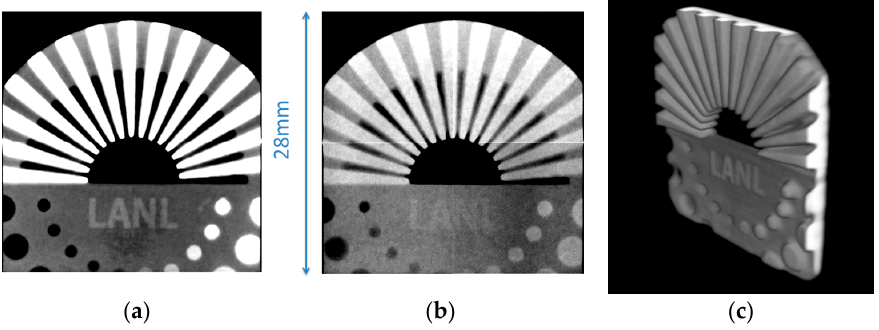
Figure 11. Thermal neutron radiograph ( a ), epithermal neutron radiograph at the 18.6 eV W resonance ( b ) and CT reconstruction ( c ) of the central portion of an additively manufactured disk-shaped W test object. The thickness of the various areas is clearly visible including the LANL logo. In addition, gating on a W resonance ( b ) changes the contrast, making the non-W inclusions around the logo less visible.